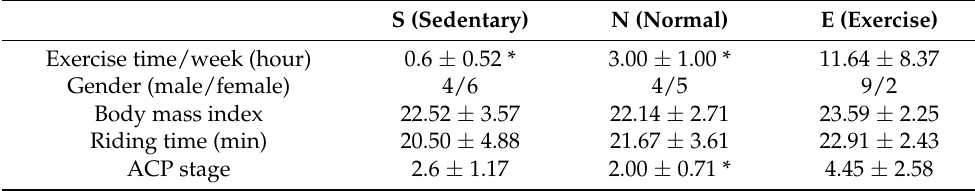
Table 1. Participant